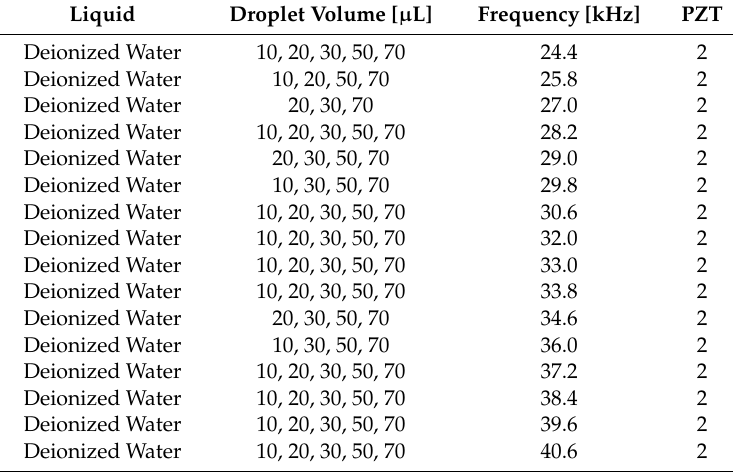
Table A6. Testing parameters used for the experiments conducted with deionized water to investigate the e ff ects of vibration